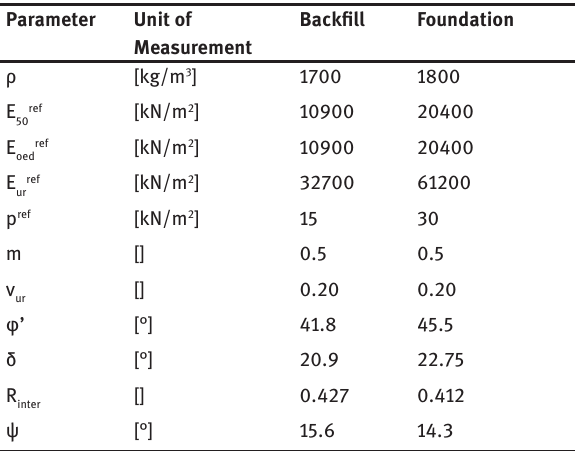
Table 3: Hardening Soil Model Parameters. Parameter